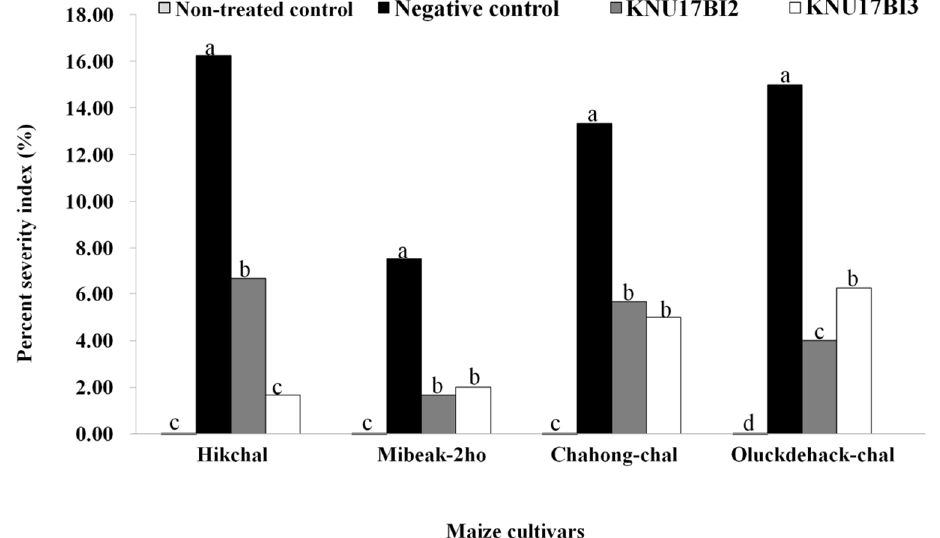
Figure 8. Effectiveness of strain KNU17BI2 and strain KNU17BI3 for the control of root rot of maize caused by F . temperatum in greenhouse. Percent severity index (mean of three replications having 10 plants per replication) assessed 30 days after treatment. Mean values having the same letter(s) in each cultivar are not statistically different ( p ≤ 0.05) according to DMRT test. Non-treated plants (neither pathogen, nor Burkholderia strains) were served as non-treated control and non-bacterized plants, but pathogen-challenged were served as negative control.